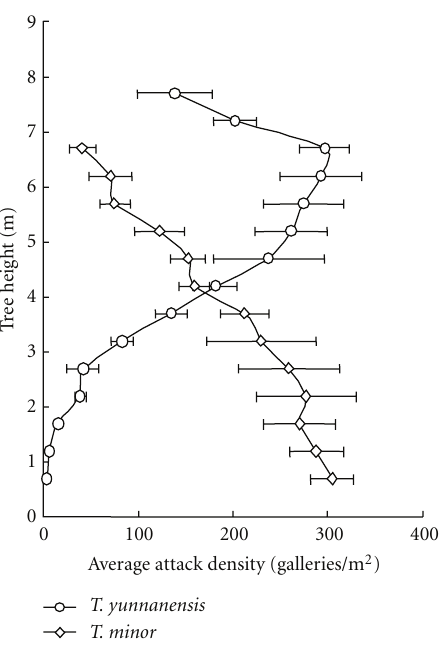
Figure 3: Average attack (egg gallery) density ( ± SE) and distribu- tion of T. yunnanensis and T. minor along the trunks of Yunnan pines in January, 2006 (Qujing, Yunnan province, China).